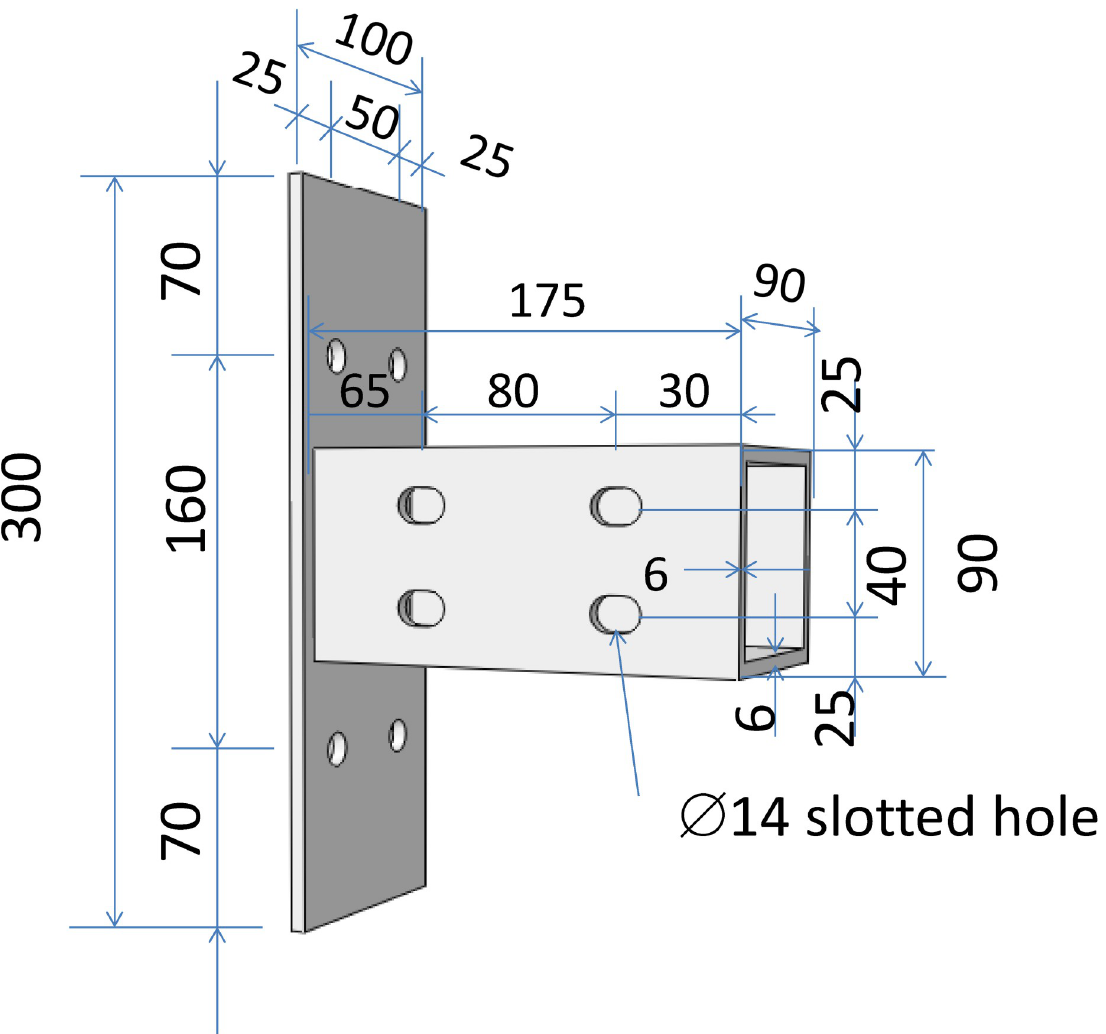
Fig 2. Details dimensions of tubular connectors(dimensions in